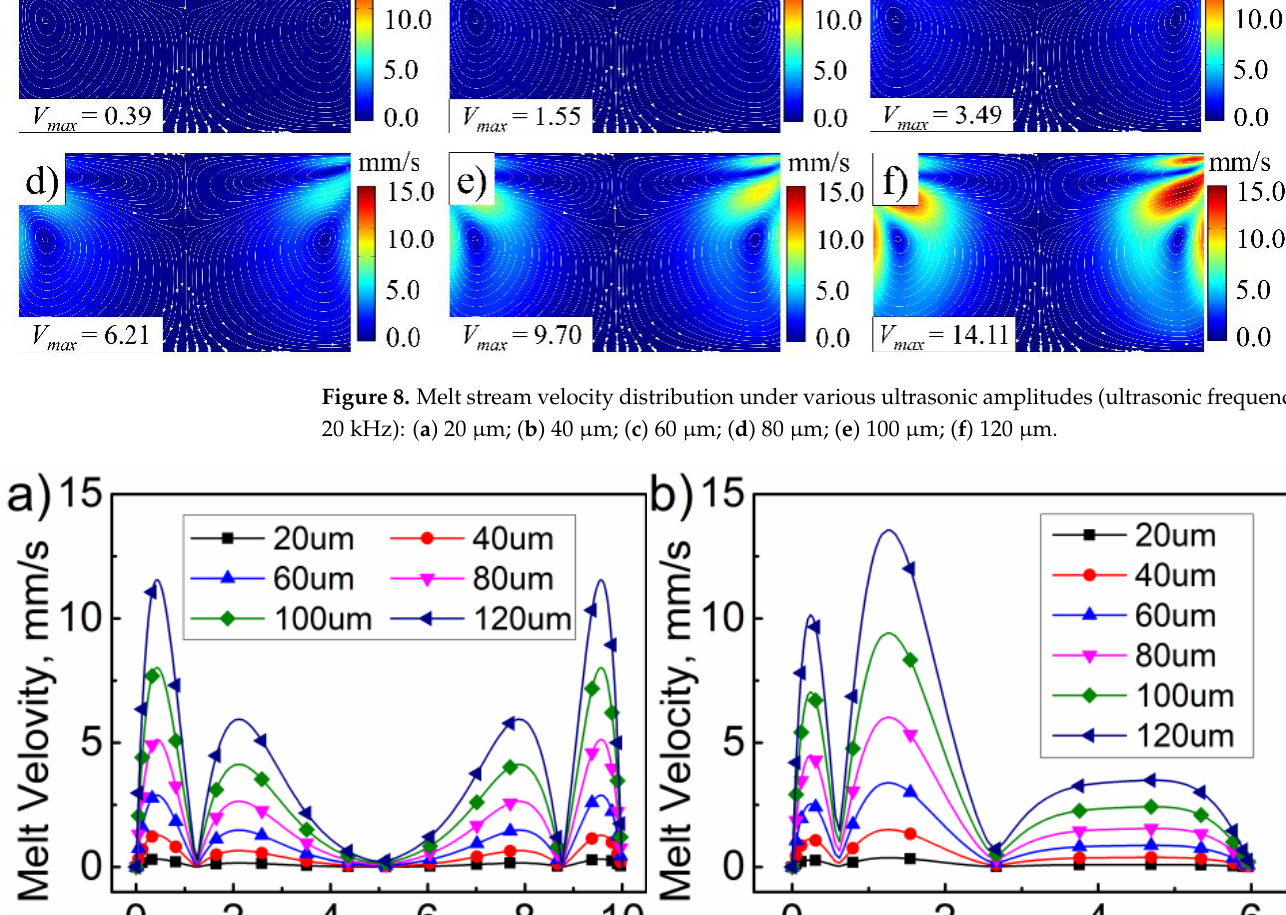
Figure 10. Total force on fluorescent particles at various amplitudes (ultrasonic frequency, 20 kHz): ( a ) 20 μm; ( b ) 40 μm; ( c ) 60 μm; ( d ) 80 μm; ( e ) 100 μm; ( f ) 120 μm. Figure 11. Trajectory of fluorescent particles at various ultrasonic amplitudes (ultrasonic frequency, 20 kHz): ( a ) 20 μm; ( b ) 40 μm; ( c ) 60 μm; ( d ) 80 μm; ( e ) 100 μm; ( f ) 120 μm. As discussed in Section 4.1, the total force is approximately equal to the Stokes drag force, which is linearly related to the velocity difference between the melt and the fluores- cent particles, according to Equation (14). The melt stream velocity can be increased expo- nentially with increasing ultrasonic amplitude, as demonstrated in Figure 8. Therefore, it can be drawn that the total force can also be changed exponentially with increasing ultra- sonic amplitude. This is indeed the case, as we found in the numerical simulation. The maximum value of the total force increased from 1.91 × 10 − 5 N to 6.86 × 10 − 5 N while maintaining the distribution pattern when the ultrasonic amplitude increased from 20 μm to 120 μm, as illustrated in Figure 10. Another factor that can be related to the total force distribution of the fluorescent particles is viscous heating induced by ultrasonic excitation. As the ultrasonic vibration